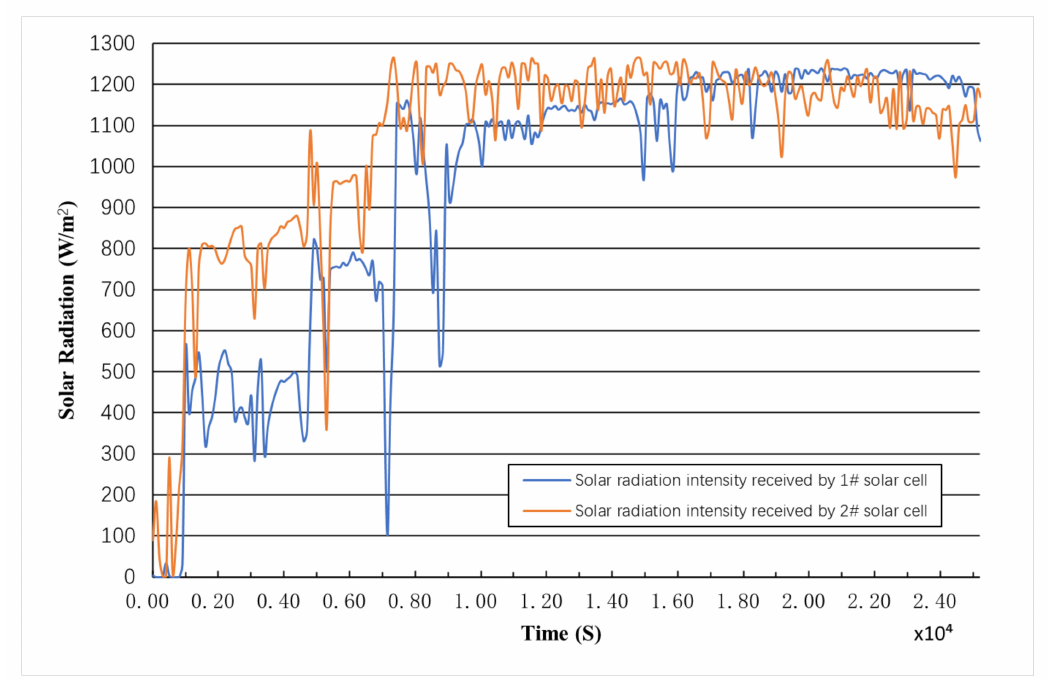
Figure 7. Measured solar radiation intensity on two solar cell modules during a flight